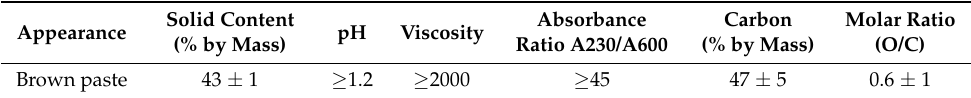
Table 2. The properties of graphite